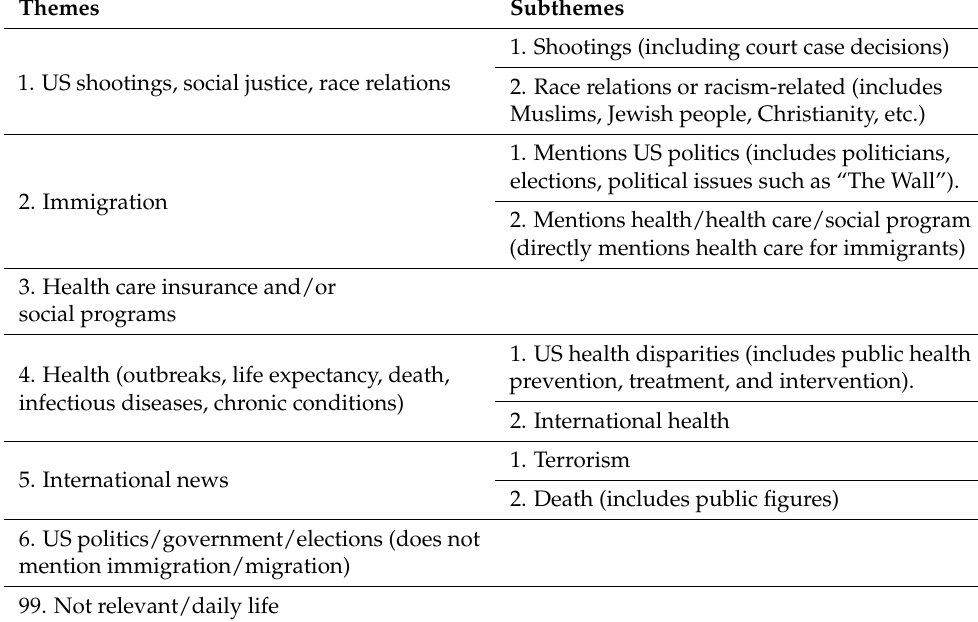
Table 2. Qualitative